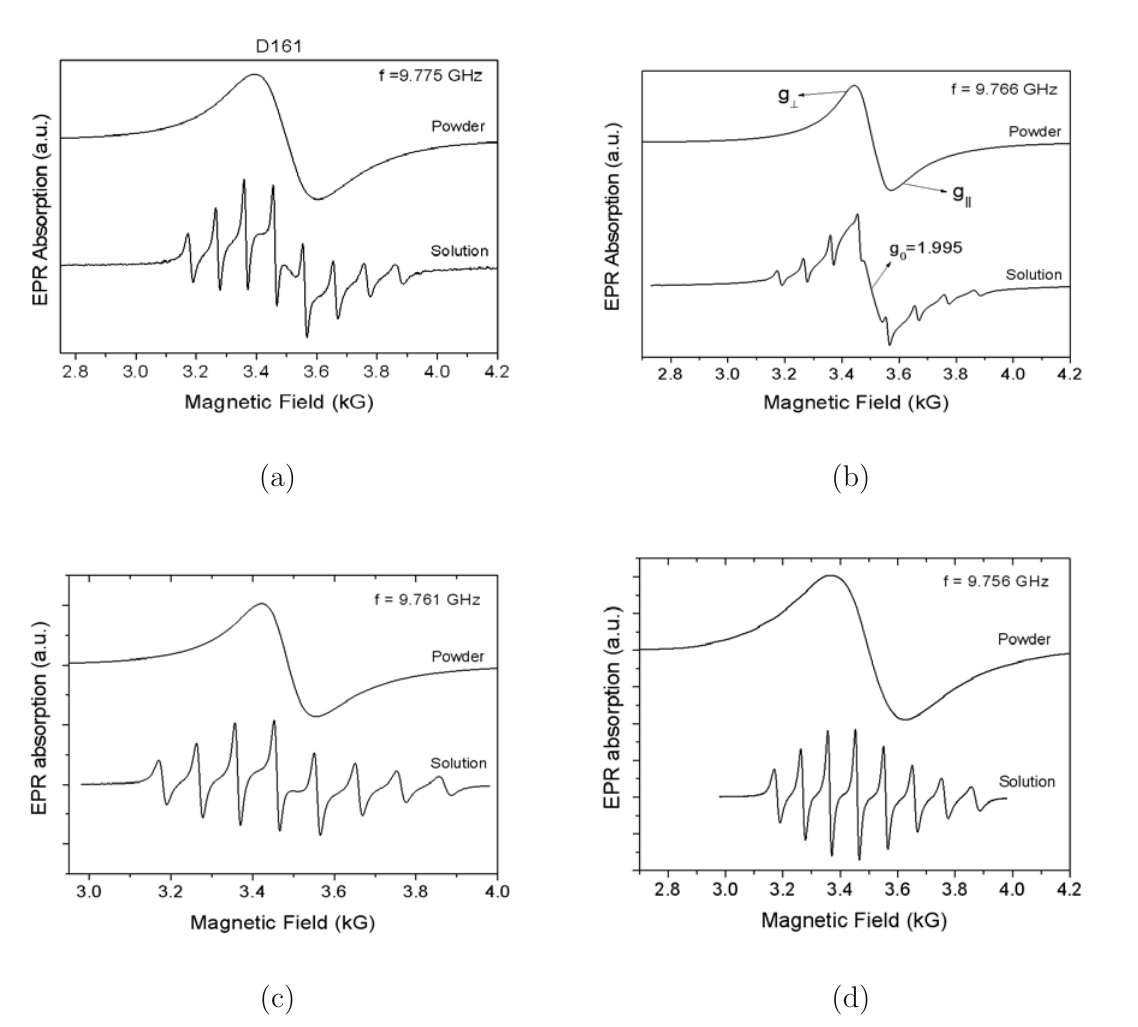
Fig. 2 The room temperature EPR spectra taken from powder and solution forms of (a) [VO( L II )], (b) [VO( L I )], (c) [VO( L III )] and (d) [VO( L I I II I ) + c(m ) 2 [30], where a, b, c are line width coefficients, m LW= a + b(m I I